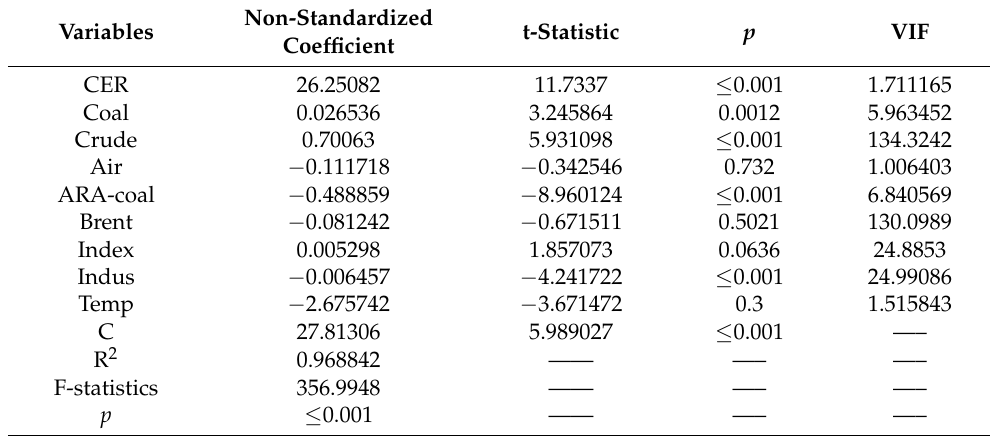
Table 7. OLS regression